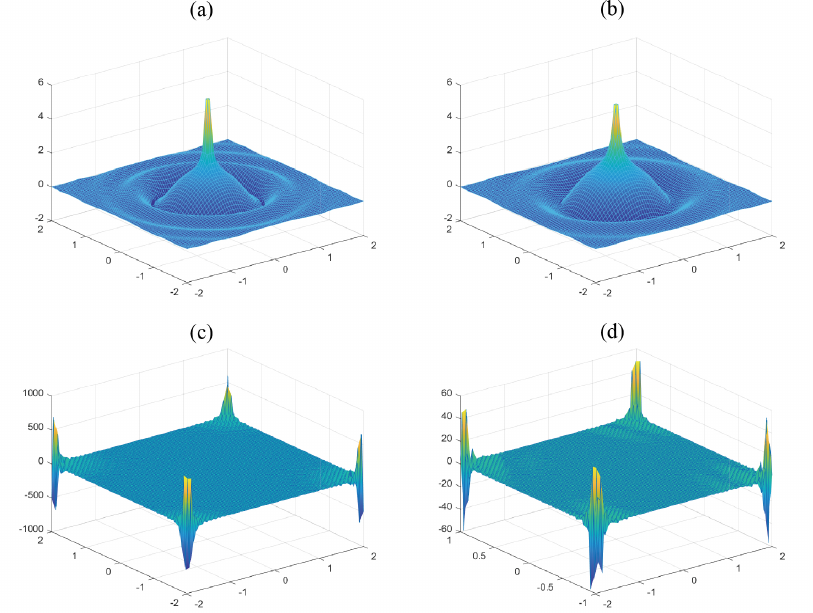
Figure 2. ( a ) Real part graph of f ( x ) , ( b ) real part graph of Step 1, ( c ) real part graph of Step 2, ( d ) real part graph of Steps 3 and 4, where Steps 1, 2, 3, 4 are the decomposition of 2D-LCT of f on Page 3.